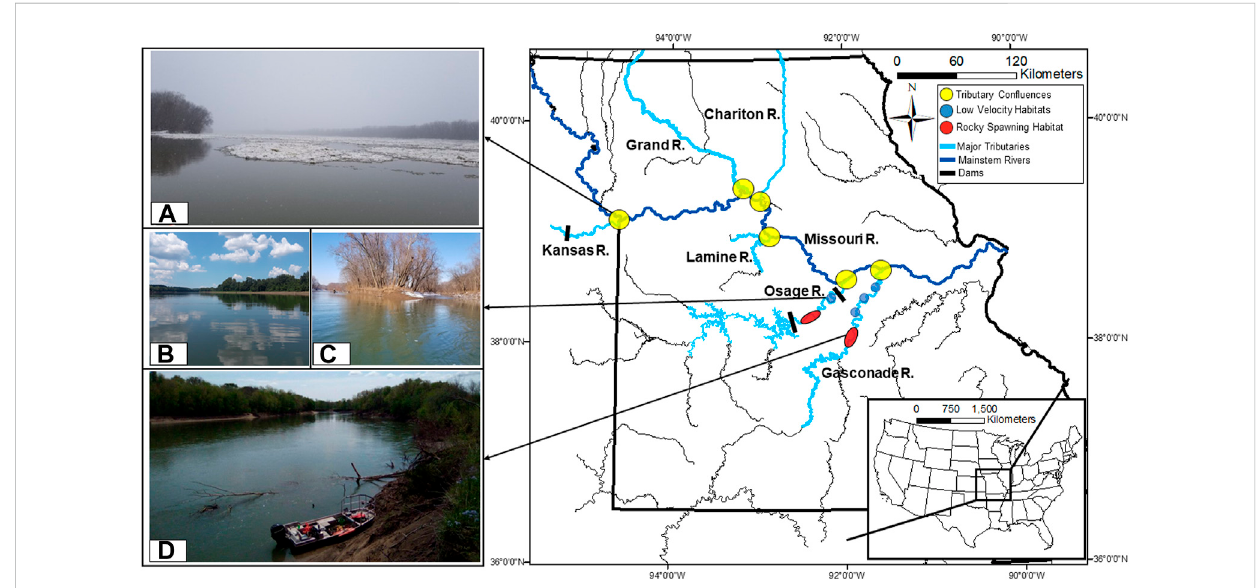
FIGURE 1 StudyareamapforthelakesturgeoncasestudyinlowerMissouriRiver,highlightingthestateofMissouriandmajortributariesusedbylakesturgeon. A diversity of ecoregions (different colored regions) provides unique supplementary and complementary habitats. Speci fi c types of habitats used by lake sturgeon are illustrated by the accompanying photos including (A) low-velocity resting habitat at the Missouri River-Osage River con fl uence during winter, (B) deep, gravel-dredge pool in Osage River, (C) side channel/backwater in Gasconade River used as stopover habitat on spring migrations, and (D) spawning shoal used by large river fi shes for reproduction and for which lake sturgeon were present at time of photo. Photographs by Michael Moore, Missouri Cooperative Fish and Wildlife Unit, University of